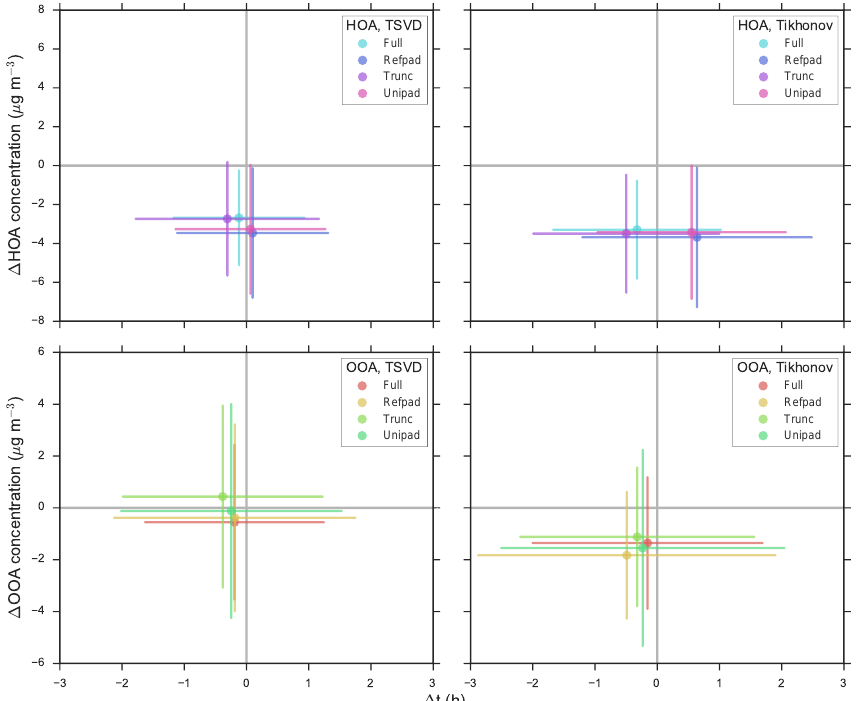
Figure 8. Peak plots for time series of period 57h measured with 4h samples subject to 20% measurement uncertainty recovered by each of the eight combinations of regularization (TSVD, Tikhonov) and boundary value (full, trunc:truncated, unipad:uniformly padded, refpad:reflectively padded) methods. The peak plots are explained fully in the main text in Sect. 4. Briefly, (cid:49) [HOA or OOA] concentration represents the mean difference in daily peak concentrations and (cid:49) t the mean difference in daily peak timing between a calculated, hourly resolved time series and its corresponding true time series. The vertical and horizontal bars represent 1 standard deviation of the (cid:49) [HOA or OOA] concentration and (cid:49) t results, respectively, for each daily peak in all of the modeled solutions.